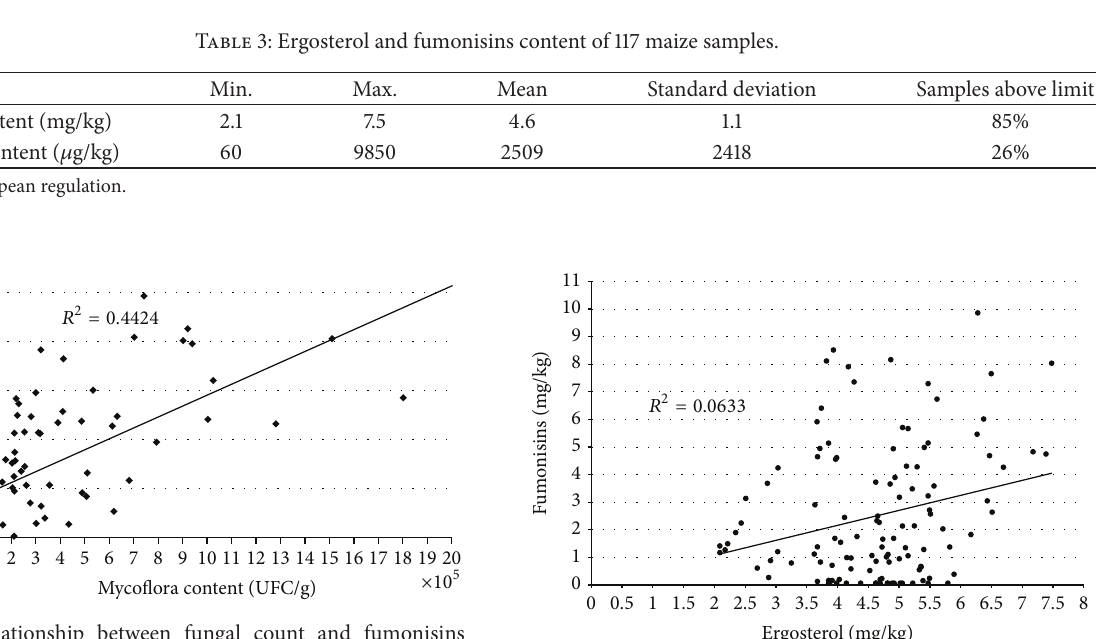
Figure 3: Relationship between ergosterol and fumonisins contam- ination based on 117 samples of